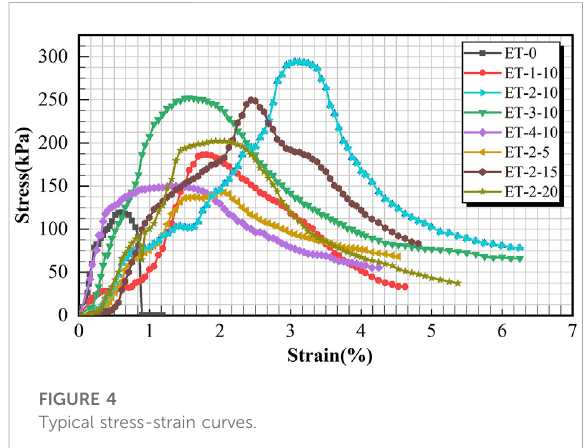
FIGURE 4 Typical stress-strain